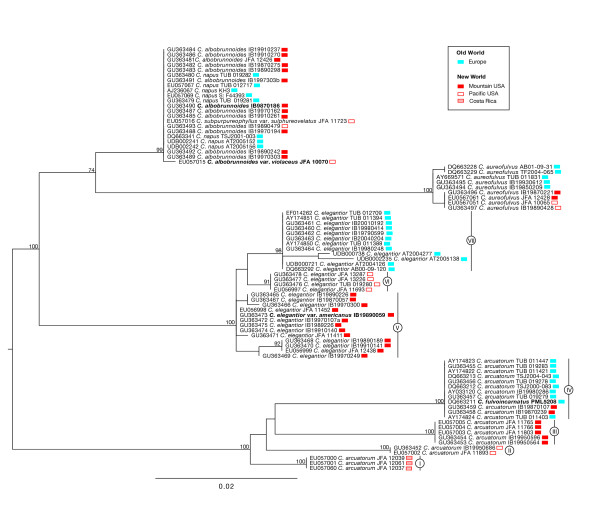
Phylogenetic relationships of New World and Old World population samples of Calochroi species based on ML analysis of ITS rDNA sequences. The represented tree was computed from 1000 runs and was mid-point rooted. Numbers above branches are bootstrap values (values < 70 not shown) from 1000 replicates. Assignations I to VII indicate major groups of C. arcuatorum and C. elegantior discussed in the text. Type specimens are printed in bold.